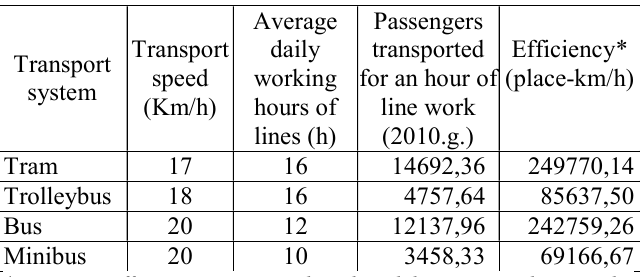
Table 2. Transport efficiency